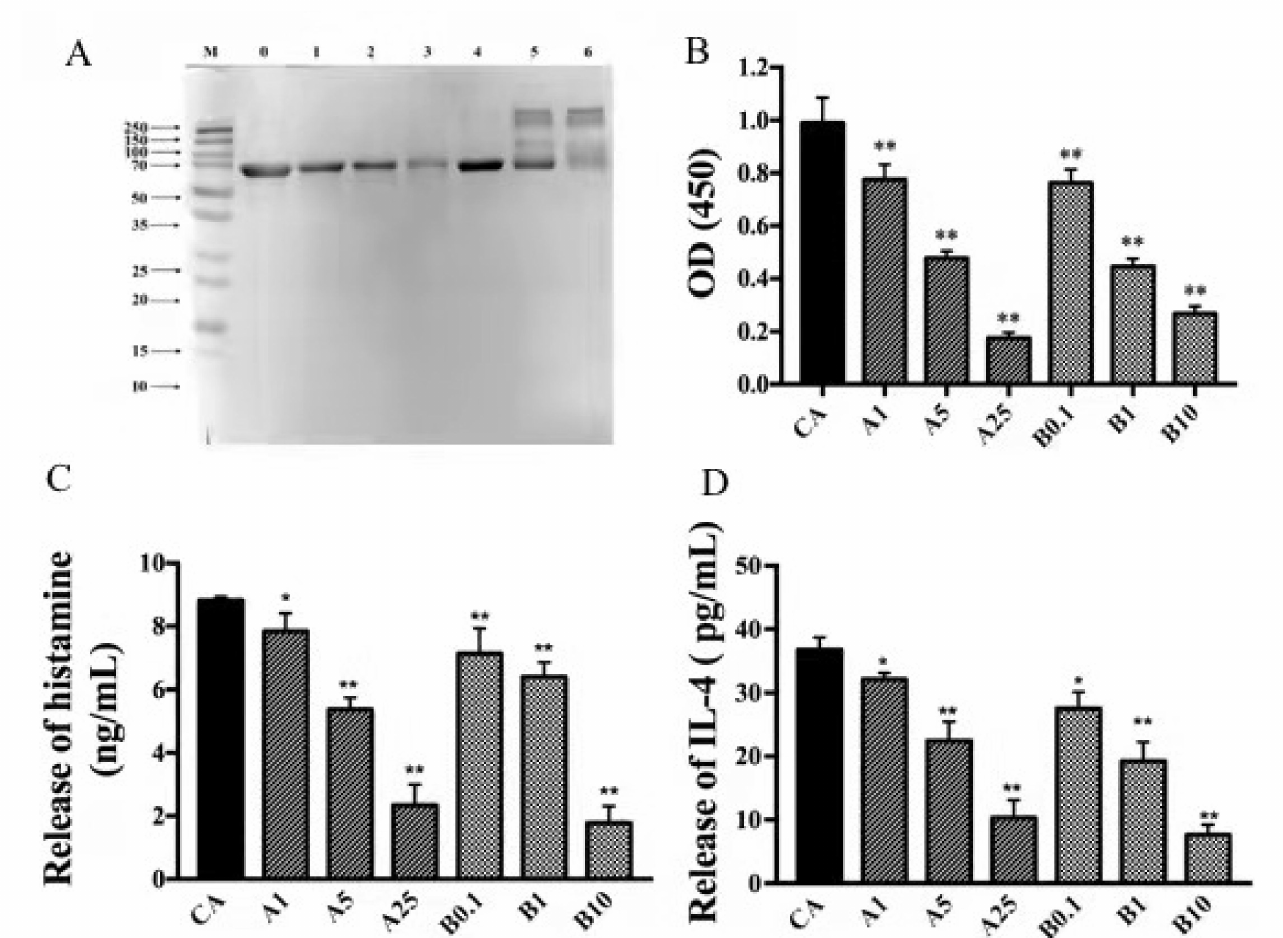
Figure 6. In vitro allergenicity assessment of CA oxidation complexes. ( A ) IgE-binding capacity of AAPH-CA and acrolein-CA in immunoblot analysis using pooled sera (IgE) from patients allergic to egg. ( B ) Indirect ELISA to detect the IgE-binding capacity of AAPH-CA and acrolein-CA using human serum. ( C ) Basophil histamine release with KU812 cell degranulation and ( D ) IL-4 release with KU812 cell degranulation using CA, AAPH-CA, and acrolein-CA. * p < 0.05; ** p <